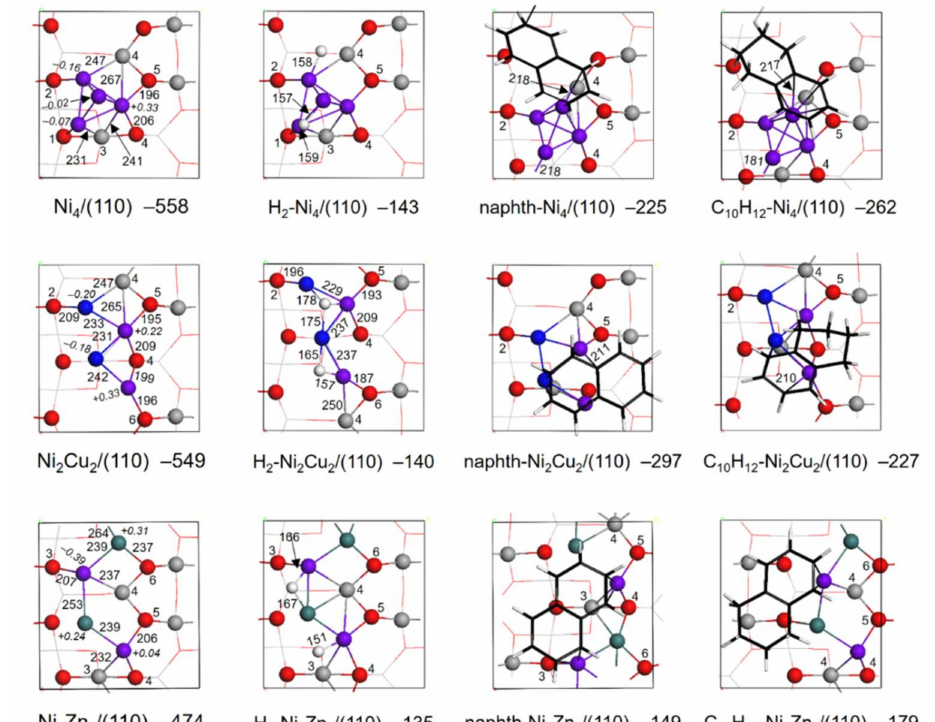
Figure 9. The structures for the adsorption of metal clusters on the alumina surface and the adsorption of H 2 , naphthalene, and tetraline on the model catalysts. The adsorption energy (kJ / mol), bond distance (pm), and Bader charge (e) are given. H, O, Al, Ni, Cu, and Zn atoms are shown in white, red, grey, violet, blue, and olive green,